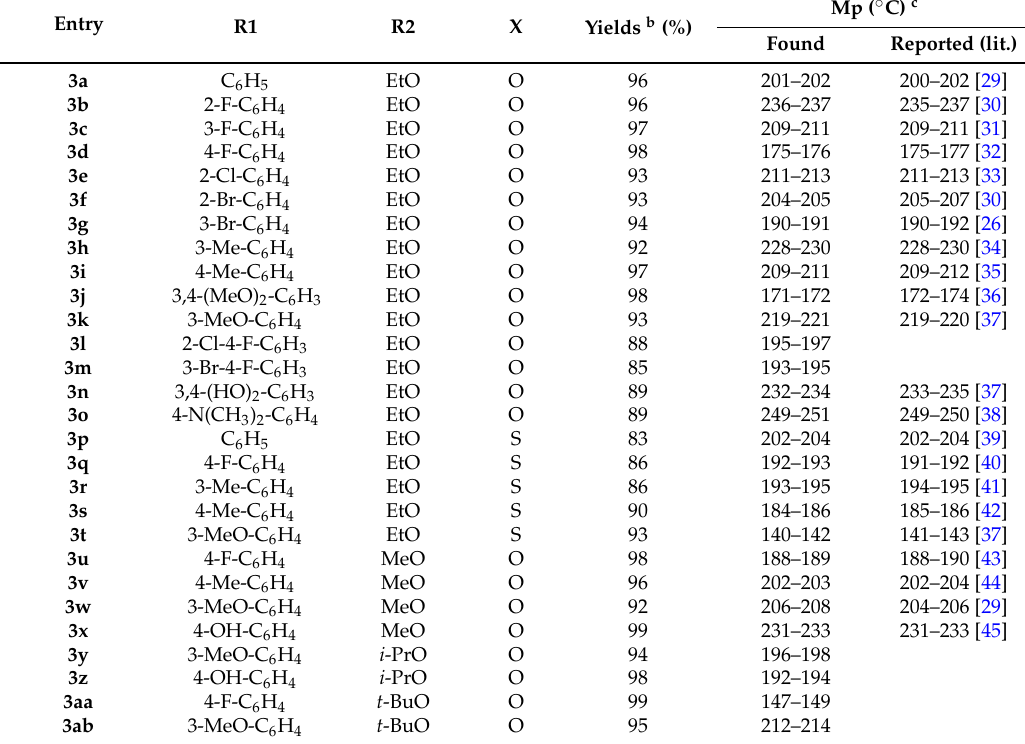
Table 2. The [C 2 O 2 BBTA][TFA]-catalyzed synthesis of 3,4-dihydropyrimidin-2(1 H )-ones a